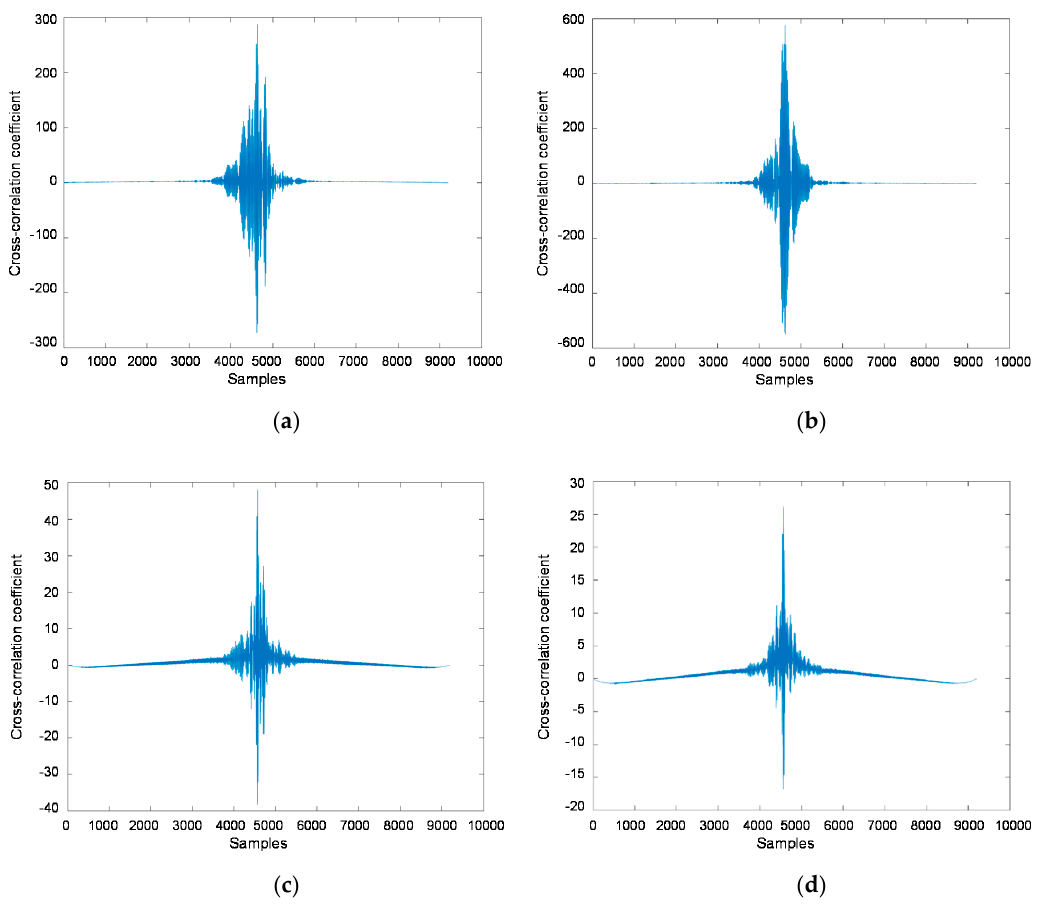
Figure 6. Cross-correlation between adjacent signals of undamaged WTB: ( a ) 200–300 mm; ( b ) 700– 800 mm; ( c ) 2,300–2,400 mm; and ( d ) 2,900 and 3,000